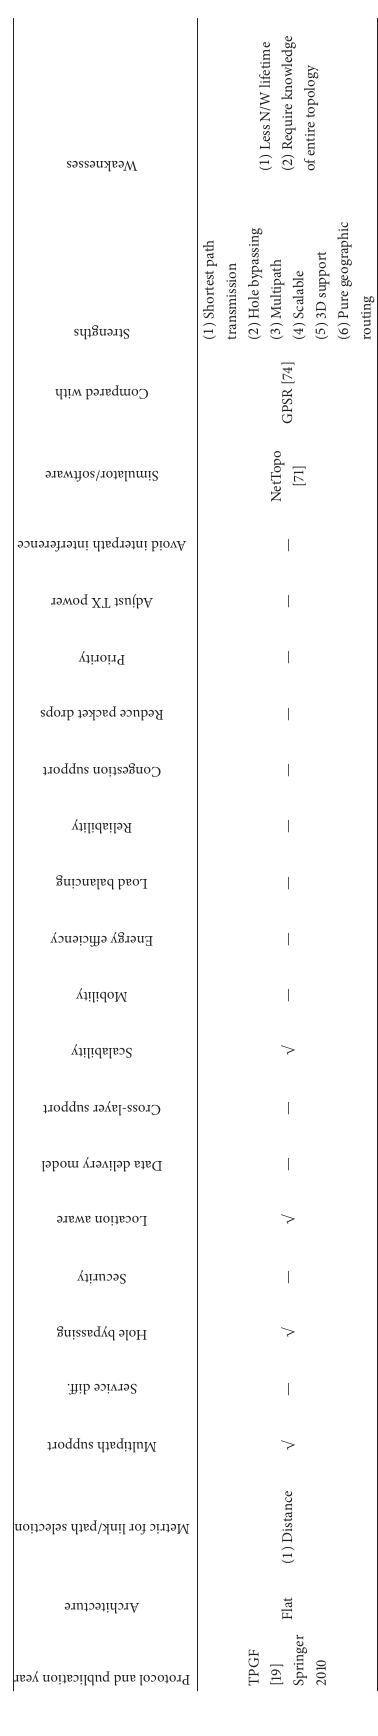
Protocolandpublicationyear